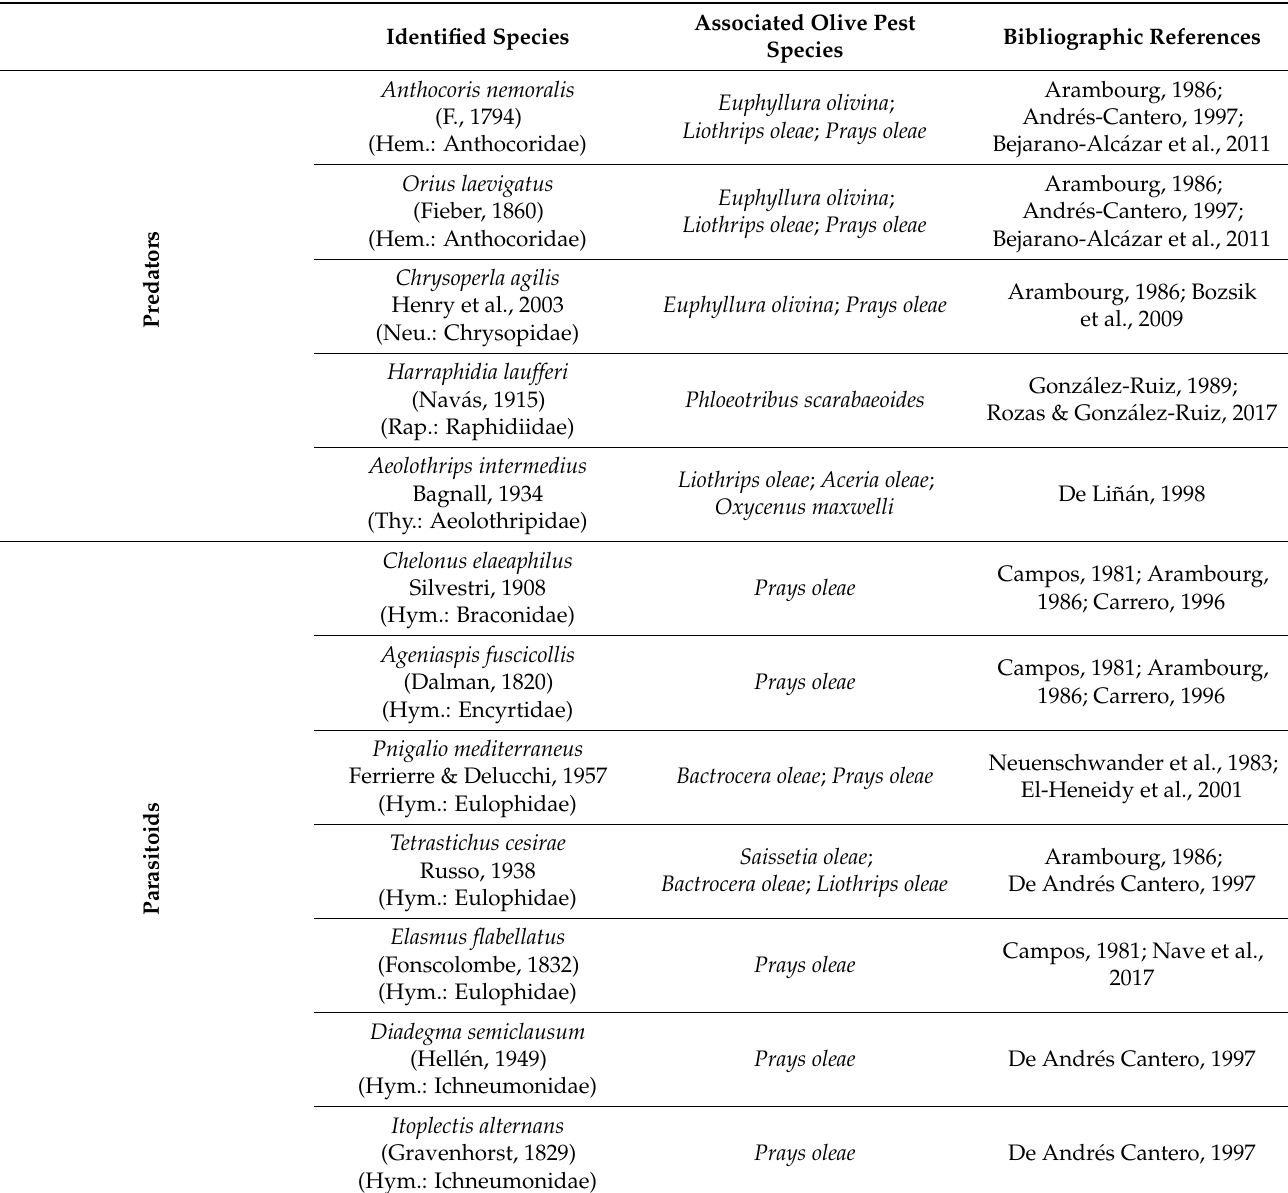
Table 2. Identified natural enemy species; olive grove pests that prey/parasitize and bibliographi- cal